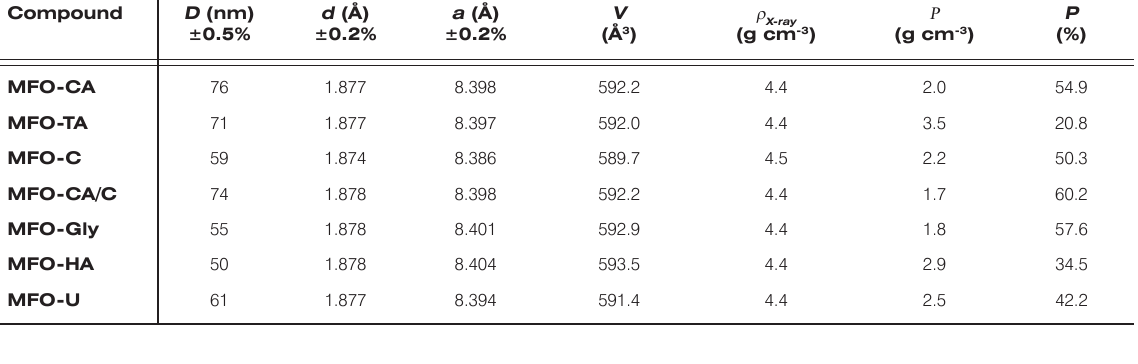
), physical density ( ρ ) and porosity X-Ray